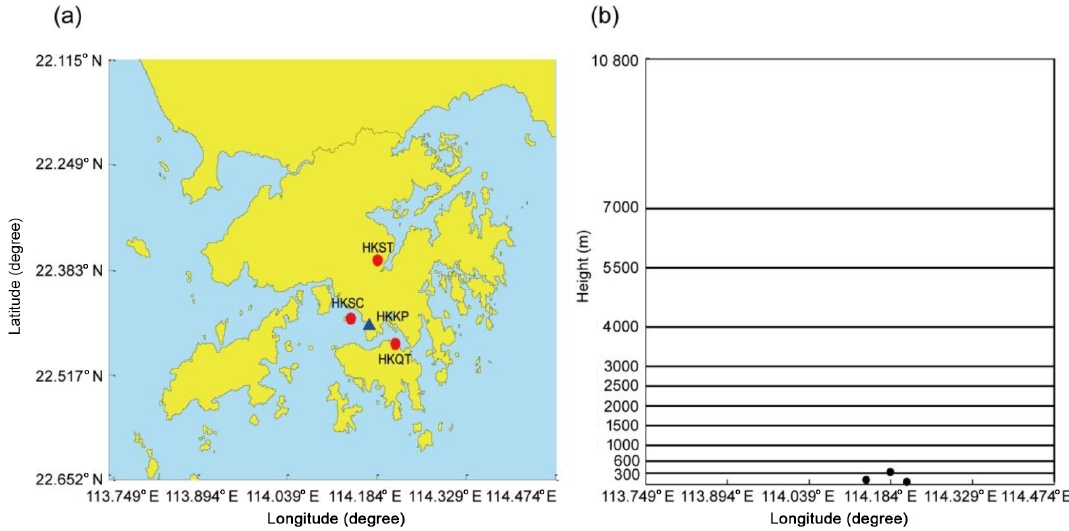
Figure 6. (a) Horizontal distribution of the three stations selected from the Hong Kong reference stations (red dots) and HKKP (blue triangle); and (b) Vertical distribution of the three stations (black spots) and vertical layers used in tomographic modeling.